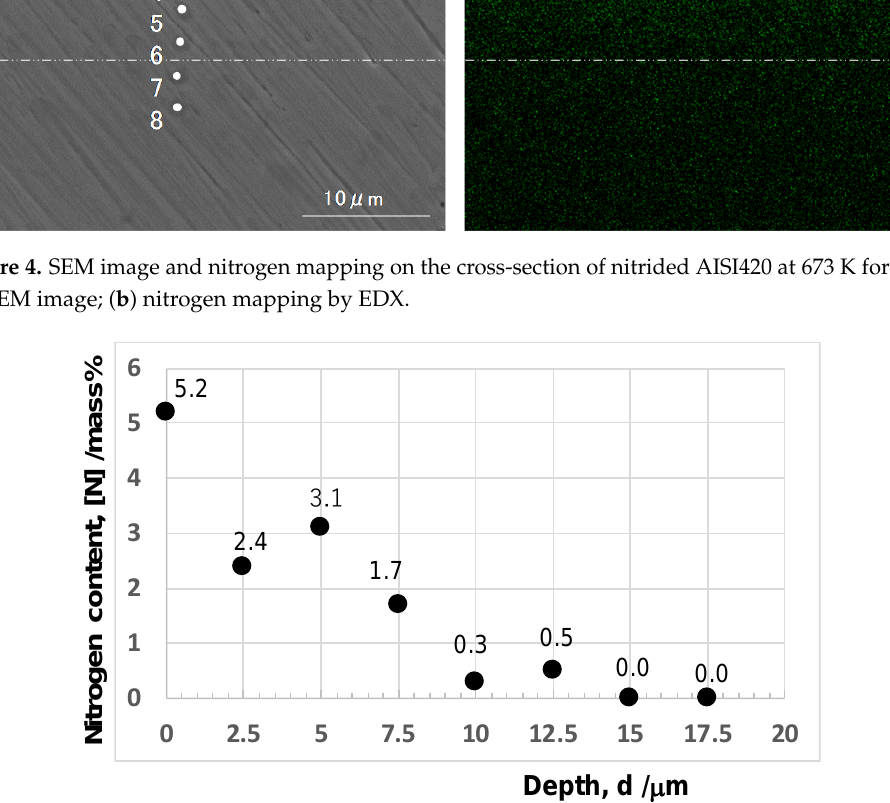
Figure. 5. Nitrogen depth profile from the surface to the depth of nitrided AISI420 at 673 K for 3.6 ks.